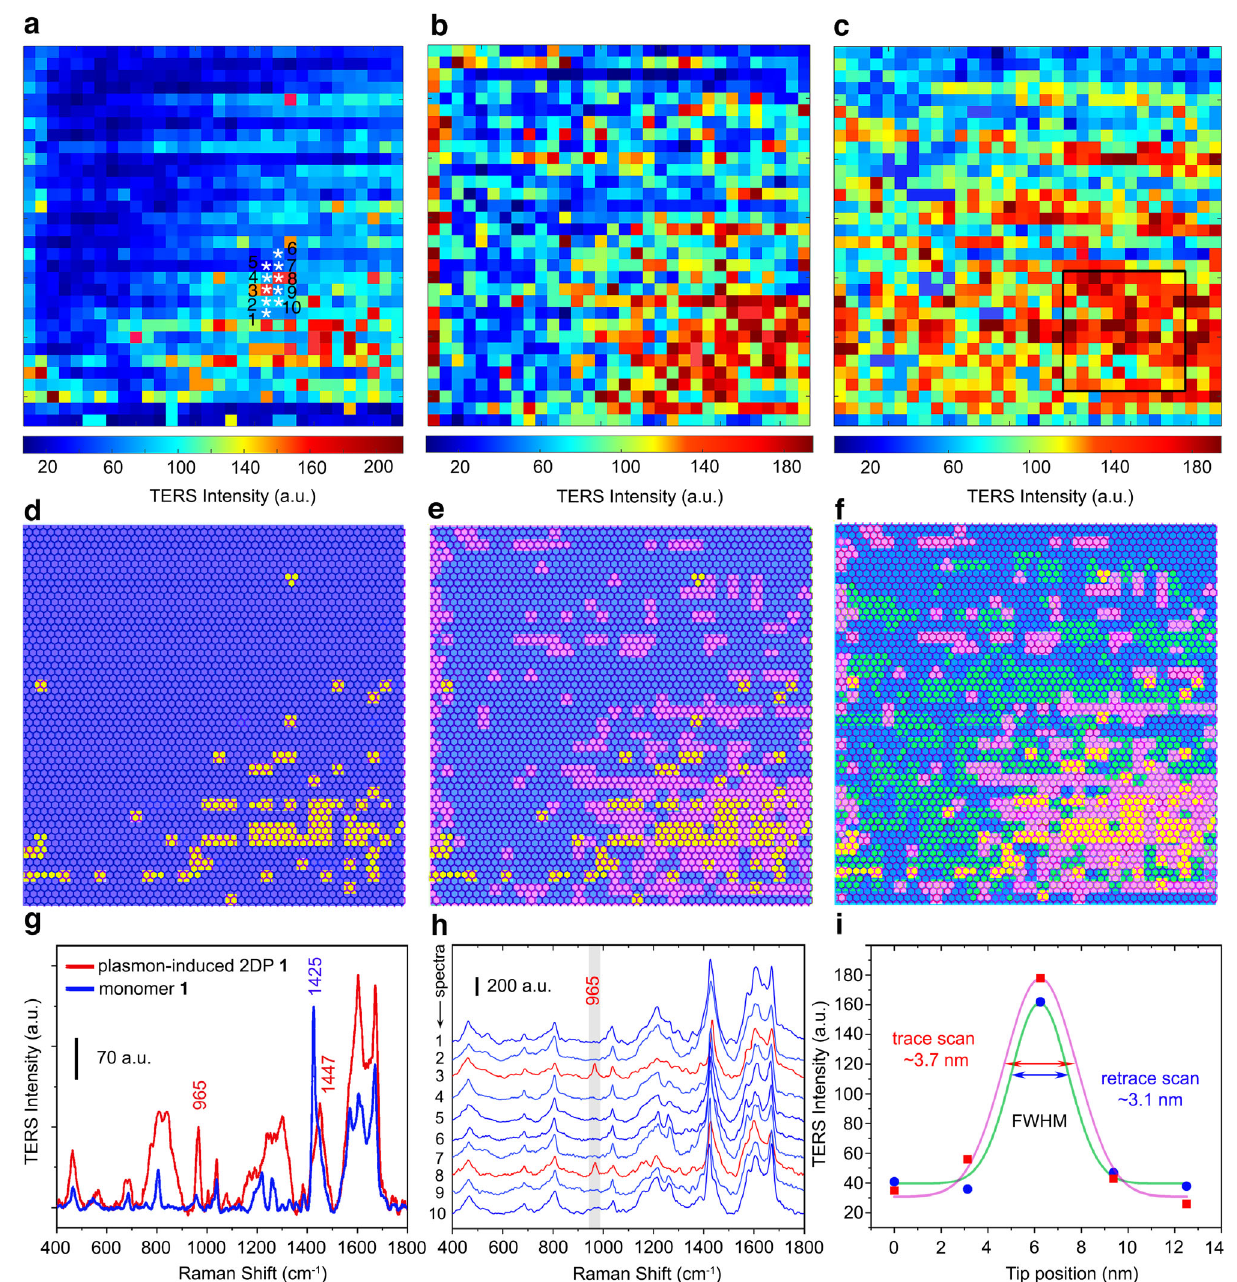
Fig. 5 Consecutive TERS imaging of the plasmon-induced 2D polymerization within monomer 1 ML on Au(111). a The 1st, b 2nd, and c 3rd TERS intensity images of the band at 965 cm − 1 . The maps were repeatedly measured over a 100 × 100 nm 2 area with 3.125 × 3.125 nm 2 pixels resolution at the same location under continuous laser irradiation (633 nm, 0.3 mW, 10 s integration). d – f Corresponding growth kinetics of the plasmon-induced [4 + 4]- cycloaddition polymerization in monomer 1 on Au(111). In order to connect the TERS maps with the chemistry of the monomer array, an arti fi cial hexagonal network was created considering relevant sizes of the monomer packing obtained from the model in Fig. 4. This network contains 55 × 55 hexagonal units. Lattice sites speci fi ed with blue areas represent the unreacted monomers and the yellow (1st imaging), pink (2nd imaging), and green (3rd imaging) areas exhibit polymerized parts based on the signal/noise criterion S/N > 4 of the band at 965 cm − 1 . g Baseline corrected average TER spectra of monomer 1 (blue curve, averaged from 1024 spectra in a ) and corresponding plasmon-induced 2DP 1 (red curve, averaged from 100 spectra in the black frame in c ). h 10 sequential TERS measurements along the line trace and retrace scans marked in a . i Corresponding TERS intensity and Gaussian fi tting of the band at 965 cm − 1 in h . The spatial resolution is estimated using a full-width at half maximum (FWHM) analysis. a.u. arbitrary (Supplementary Fig. 32 and Supplementary Note 5), TERS the Gaussian fi t (Fig. 5i). Occasionally, a plasmon-induced 2DP imaging provides rich chemical information and distinct reaction nanoribbon could be obtained from certain locations in monomer 1 ML when suf fi cient hot carriers were generated (0.6 mW, 10 s contrast for the molecular MLs at the nanoscale (Fig. 5d – f). The line pro fi le analysis suggests a lateral resolution of ~3.7 nm, integration, Supplementary Fig. 33). This may shed a light on the estimated by a full-width at half maximum (FWHM) analysis of nanolithography of 2DP monolayers by manipulating the